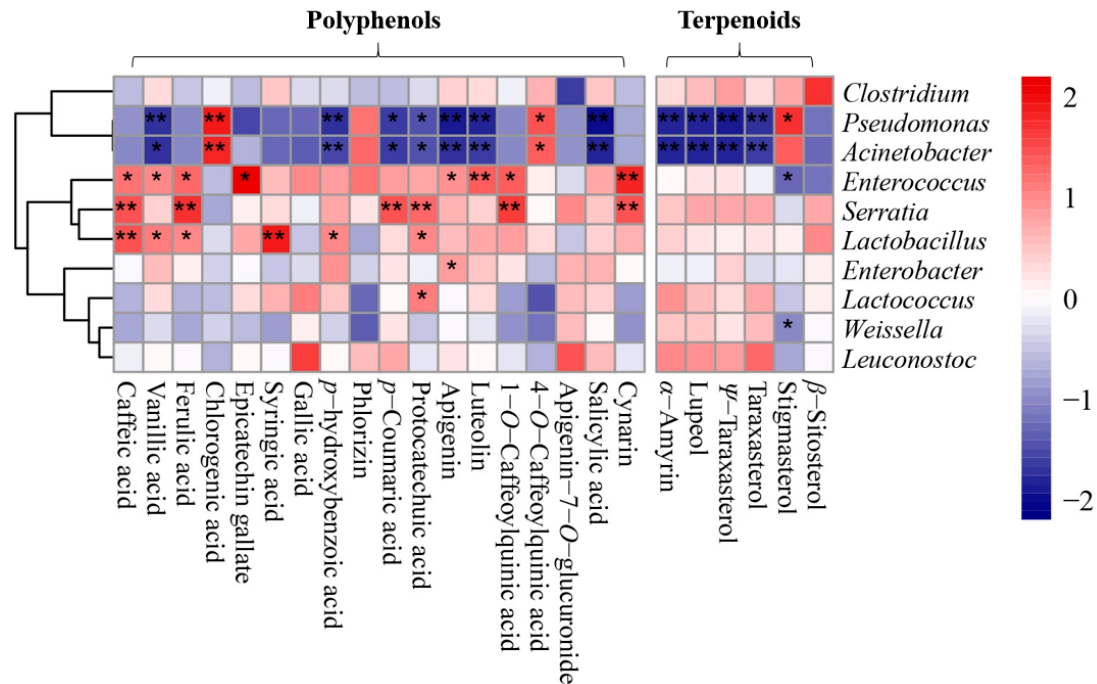
Figure 6. Correlation analysis between the relative abundance of bacterial communities and contents of polyphenols and terpenes in silage. * p < 0.01, denoting a significant correlation between the abundance of the bacterial community and levels of the substance with time. ** p < 0.05, denoting an extremely significant correlation between the abundance of the bacterial community and levels of the substance with time.